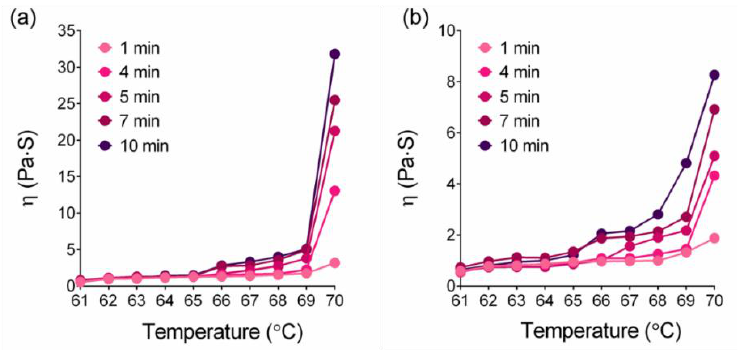
Figure 1. Effect of heating temperature and time on LEY viscosity. ( a ) Shear rate of 10/s. ( b ) Shear rate of 100/s.